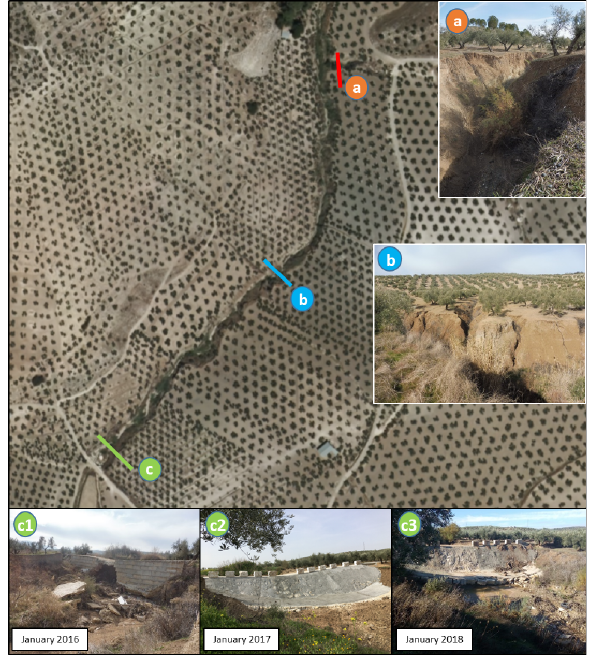
Figure 2. Photographs of different sectors of the gully area. (a): V-shape of a section at a tributary gully. (b): soil slab fall at the steep sidewalls. (c): Damages affecting a rural path due to upstream erosion from 2016 to